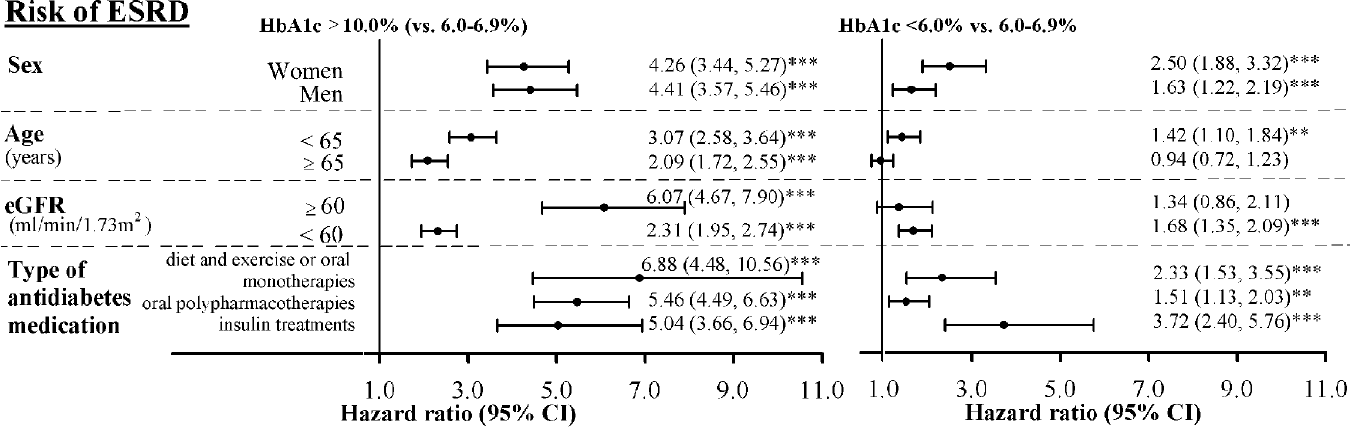
Fig 2. Adjusted HRs and their 95% CIs for ESRD based on HbA1c levels of (cid:1) 10.0% and < 6.0%. Adjusted HRs of ESRD risk by baseline HbA1c according to sex (women or men), age ( < 65 or (cid:1) 65 years), eGFR ( (cid:1) 60 or < 60 ml/min/1.73 m 2 ), and type of antidiabetes medication (diet and exercise or oral monotherapies, oral polypharmacotherapies, and insulin treatments). The HRs were adjusted for age, sex, diabetes durations, smoking, drinking, obesity, hypertension, antihypertensive medication, hyperlipidemia, type of antidiabetes medication, baseline eGFR, neuropathy, severe hypoglycemia, DKA, HHNK, cerebral vascular accident, coronary artery disease, congestive heart failure, and cancer, except for stratified variable. Significant interaction between HbA1c and sex ( w 2 5 = 105.41, P < .001); between HbA1c and age ( w 2 5 = 38.80, P < .001); between HbA1c and eGFR ( w 2 5 = 52.42, P < .001); and between HbA1c and types of antidiabetes medication ( w 2 10 = 689.99, P < .001) on ESRD risk. ** : P < .01; *** : P < .001.